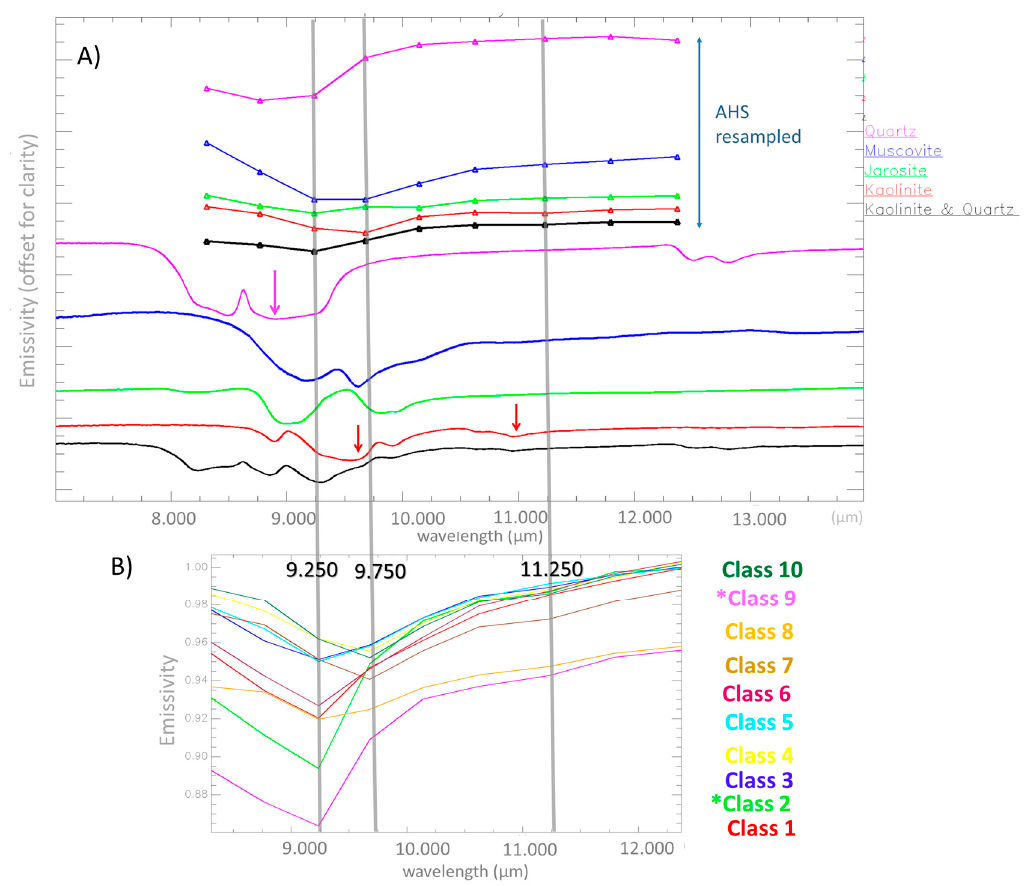
Figure 10. ( A ) Emissivity of some silicates is displayed using the Arizona University Spectral library [68], the original spectra are displayed together with the equivalent spectra resampled to the spectral resolution of the AHS data. ( B ) The average class spectrum derived from the AHS data. The mapped classes correspond to the mineral classes in Table 1, *Class 2 and *Class 9: two additional classes mapped when using Scenario 2.